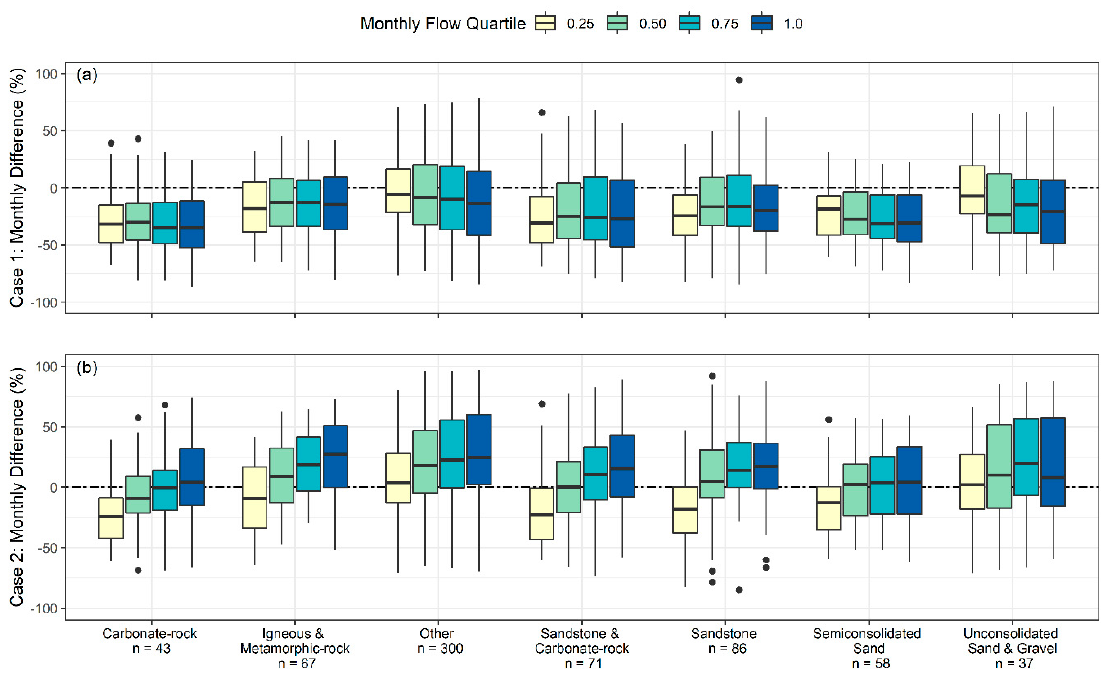
Figure 13. ( a ) The difference in average monthly percent contributions to total flow of GWF and OHS base flow (case 1), and ( b ) GWFSF and OHS base flow (case 2) over normalized monthly flow quartiles (0.25, 0.5, 0.75, 1) and aquifer type [57]. Values greater than 100 percent are due to the comparison of HRU-based volumes with routed-based stream segment volumes. The dotted line emphasizes a zero difference.